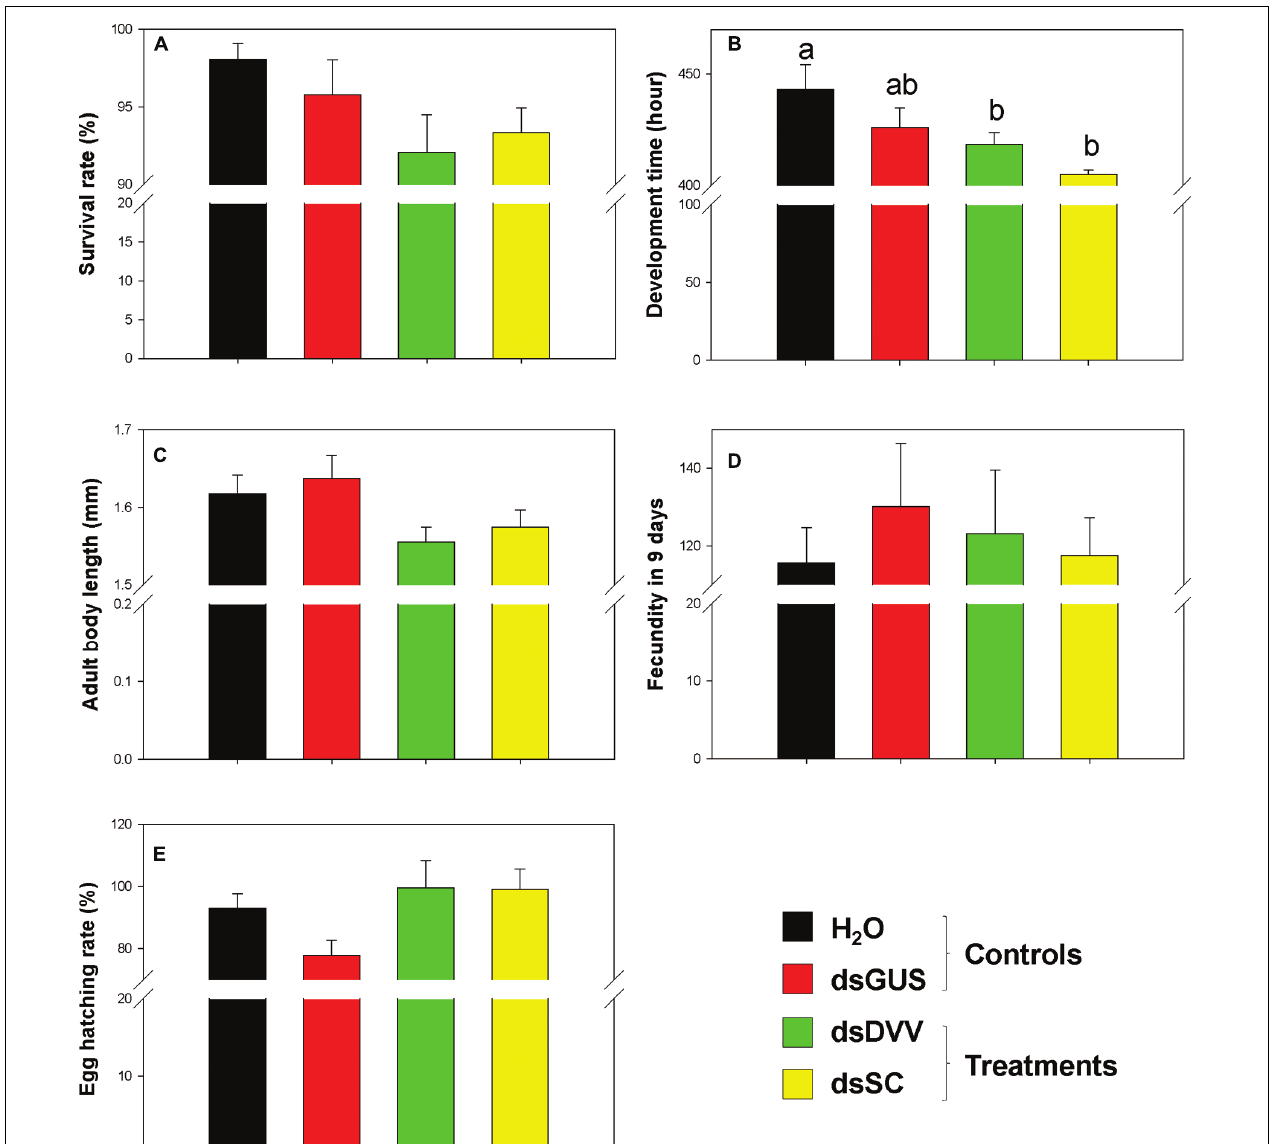
FIGURE 5 | Phenotypic impacts of dietary RNAi on S. curviseta . The endpoint measurements for S. curviseta dietary RNAi toxicity assay include survival rate (A) , and life history traits, such as developmental time (B) , adult body length (C) , fecundity (D) , and egg hatching rate (E) . See text for treatment details. Values are mean ±